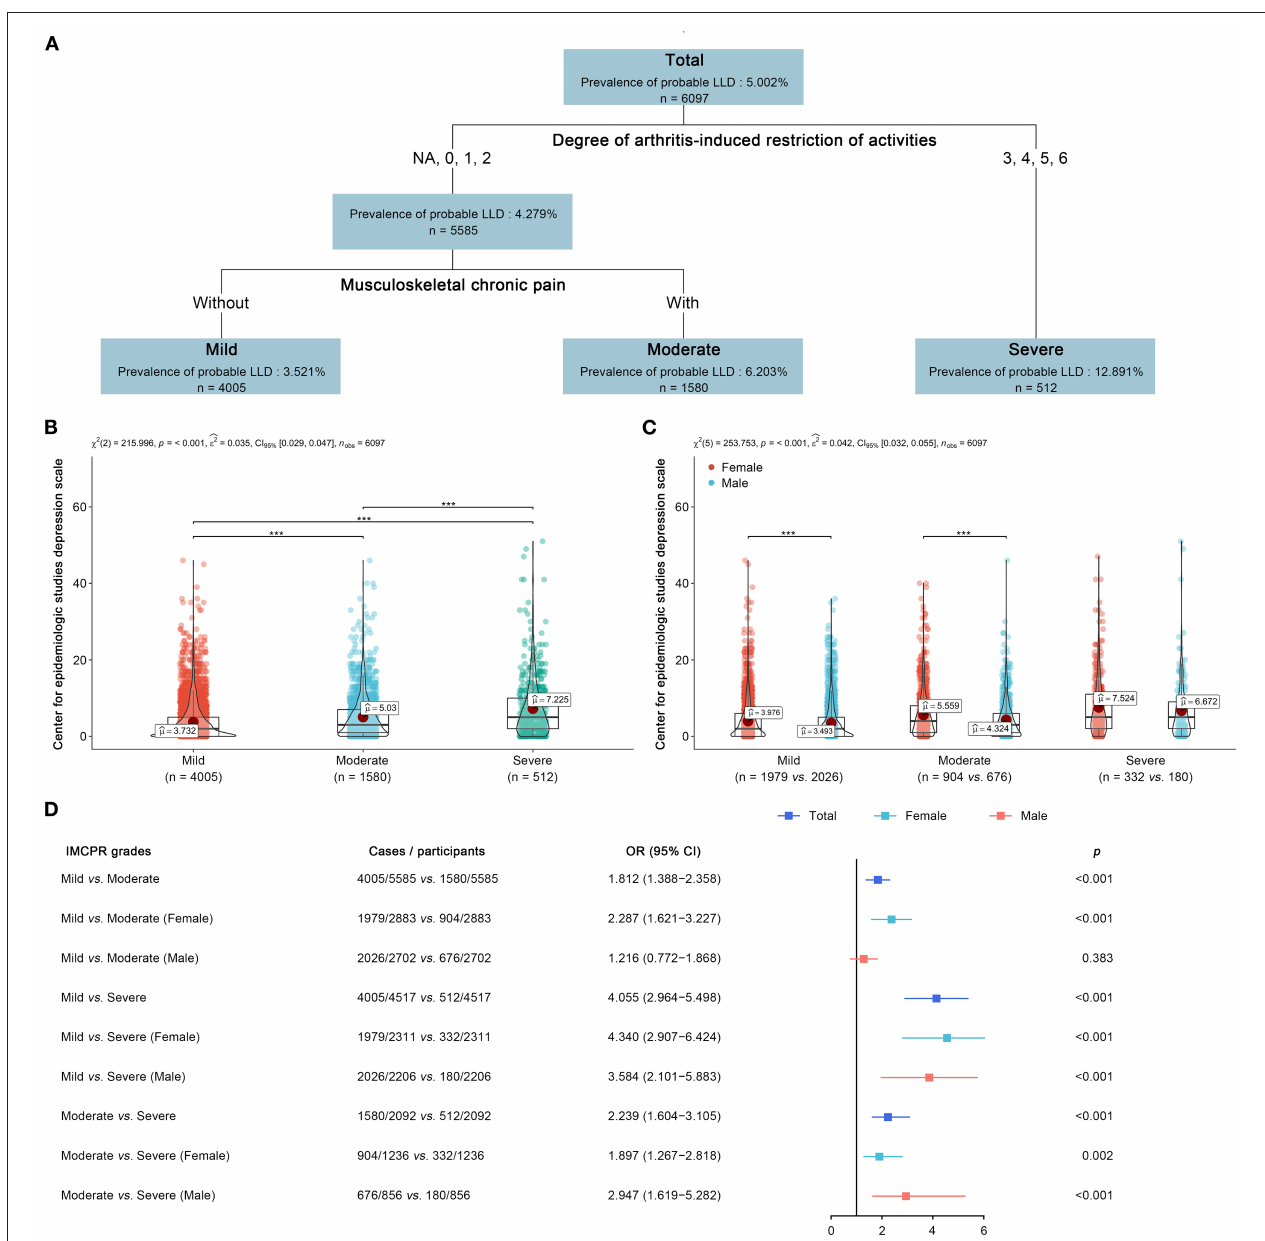
FIGURE 4 | IMC-induced negative psychological risk classification approach. (A) IMCPR classification approach was derived using tree regression . (B) Difference of depressive symptoms among participants with different IMCPR grades. (C) Potential gender-related difference of depressive symptoms among participants